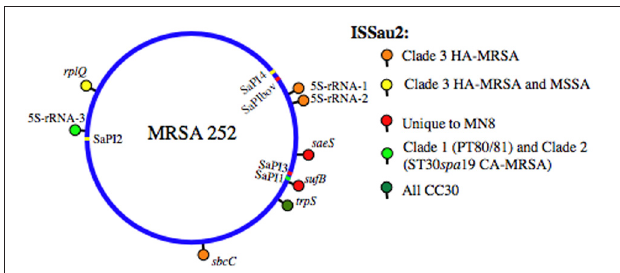
FIGURE 1 | SaPI and ISSau2 distribution in CC30. The location of each element is mapped on the reference genome of MRSA 252 [Holden et al. (2004)]. SaPIs are indicated by colored bars, on the circular blue genome, and are labeled on the interior of the circular genome. SaPI2 and SaPI4 (yellow) are unique to Clade 3. SaPI1 (light green) is present in PT80/81 (Clade 1) and ST30 spa19 CA-MRSA (Clade 2). SaPI3 and SaPIbov (red) are not in CC30, but their location is shown for reference, based on location of attS sites. ISSau2 insertions, indicated by colored lollipops above the circular genome, are named after the gene that is adjacent to each insertion. Three different 16S-23S-5S-rRNA loci are abbreviated as 5S-rRNA-1, 5S-rRNA-2, and